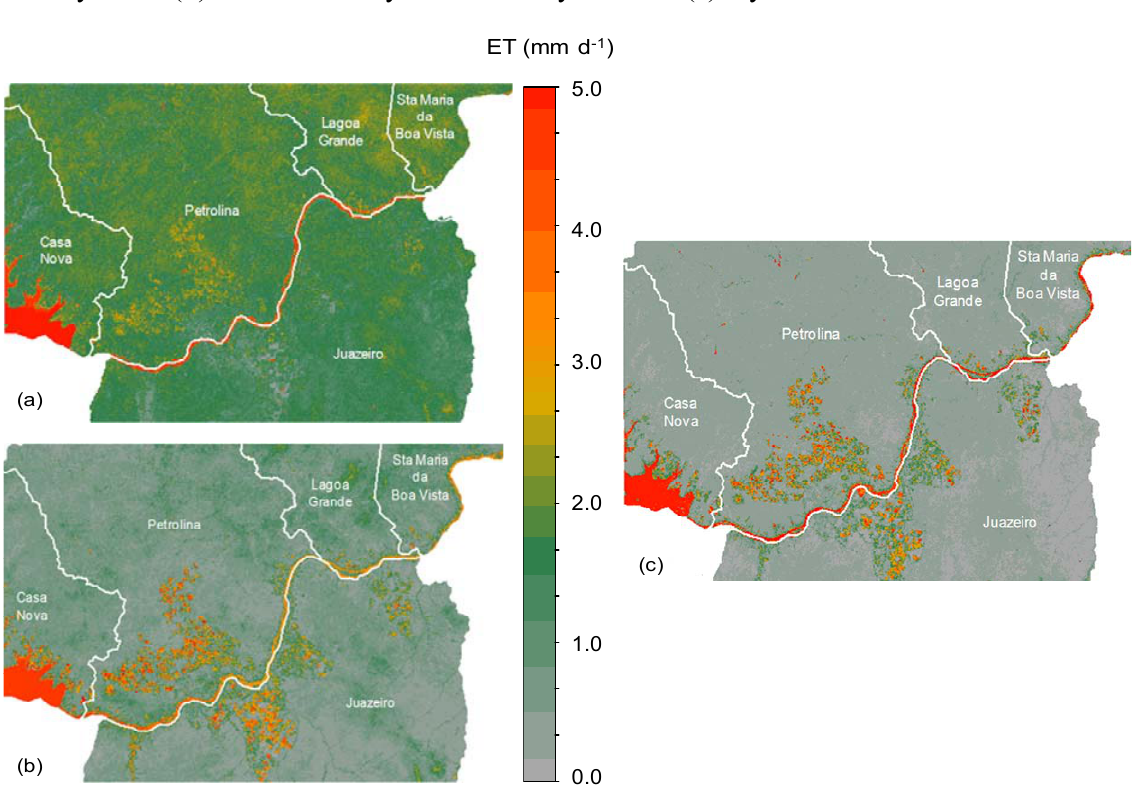
Figure 11. Daily actual evapotranspiration (ET) for the region comprised of the net of agro-meteorological stations in the Low-Middle São Francisco river basin. ( a ) wet season in January 2007. ( b ) end of the rainy season in July of 2006. ( c ) dry season in October